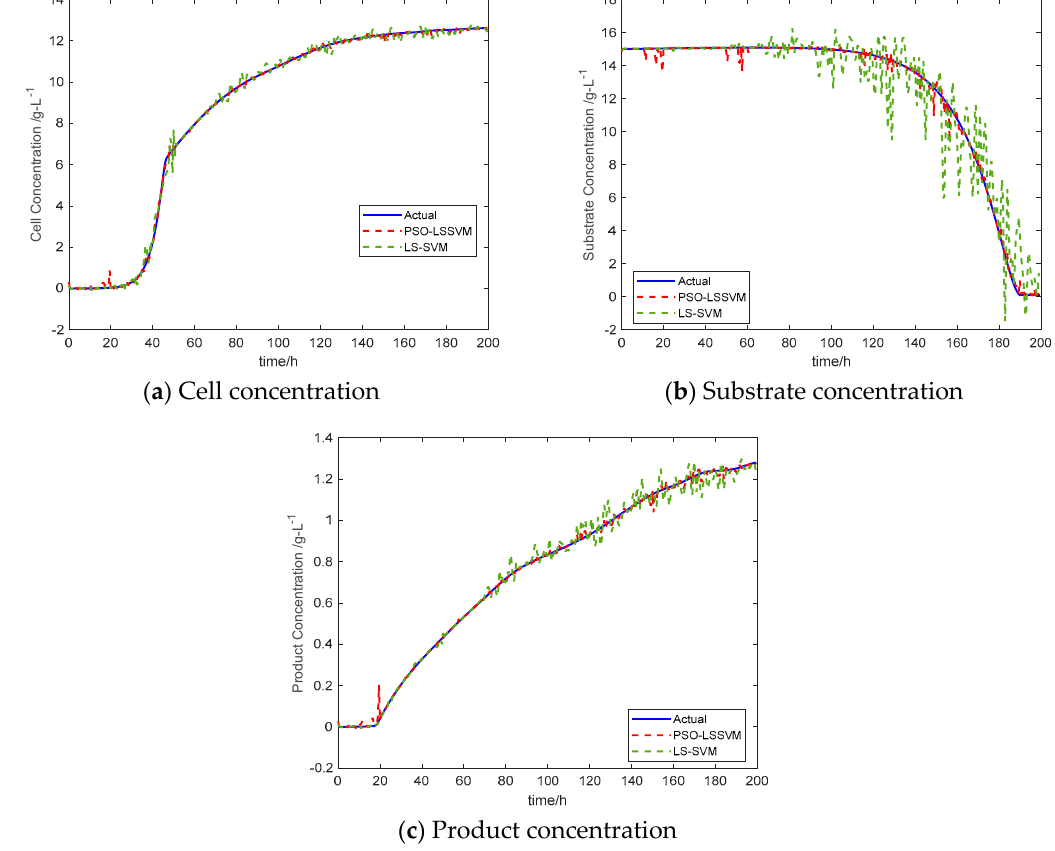
Figure 2. Comparison of soft-sensing results.